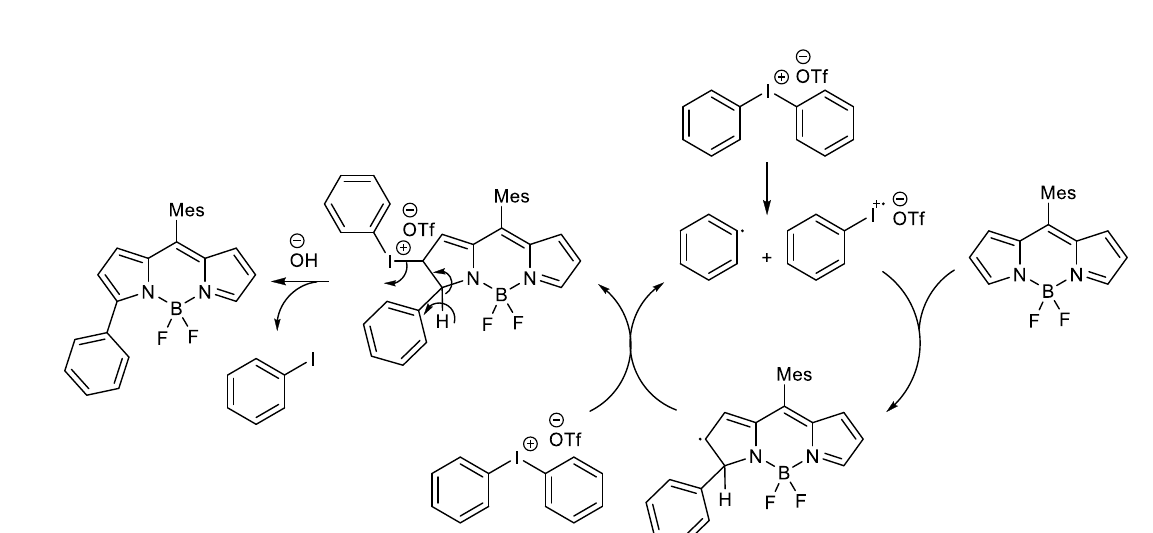
Scheme 6. Plausible radical mechanism for the regioselective synthesis of α -arylBODIPY.